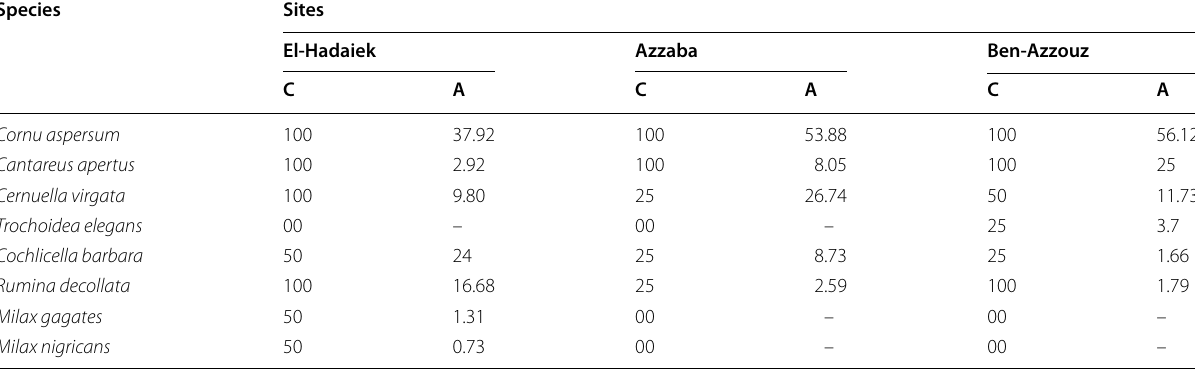
Table 4 Constancy (%) and abundance (A%) of terrestrial gastropods in the three study sites Species